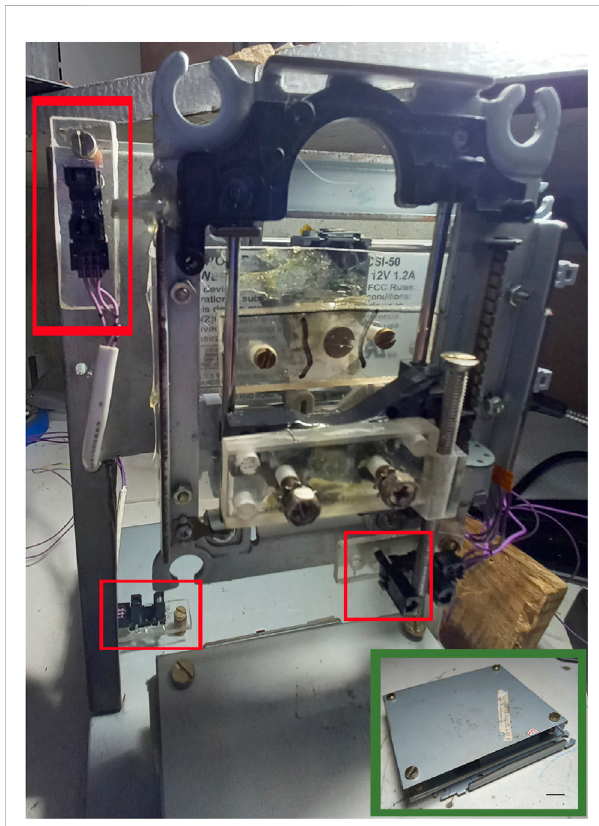
FIGURE 4 Limit switch installation with locations indicated in red squares. Insert: Mechanical assembly of the printing table. The four screws are used for leveling. Scale bar: 1 cm.